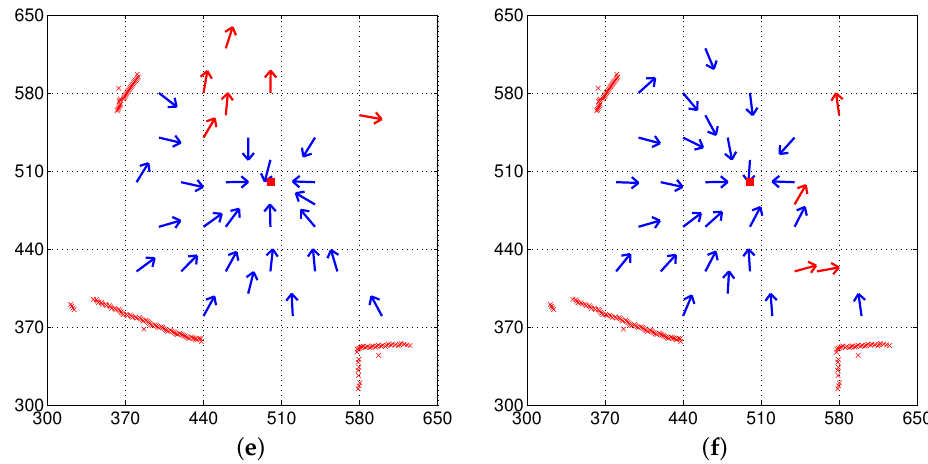
Figure 8. Vector map results with the C-DELV method (left column: with the reference compass, right column: without the reference compass); ( a , b ) env1; ( c , d ) env2; ( e , f ) env3 (x marks indicate depth sensor readings before segmentation of depth